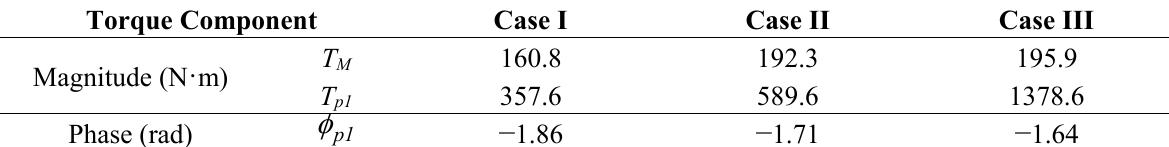
Table 2. List of the input torque profiles under various excitation conditions.